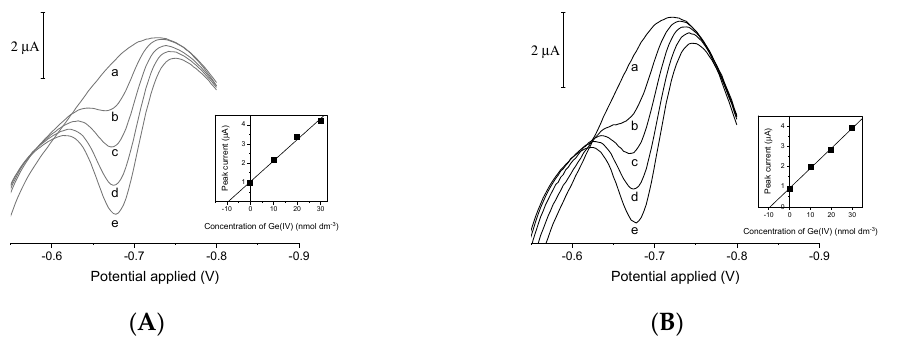
Figure 8. Voltammograms recorded by means of BiF/SPE ( A ) and BiF/SPE meso ( B ) electrodes in seawater samples (a) and